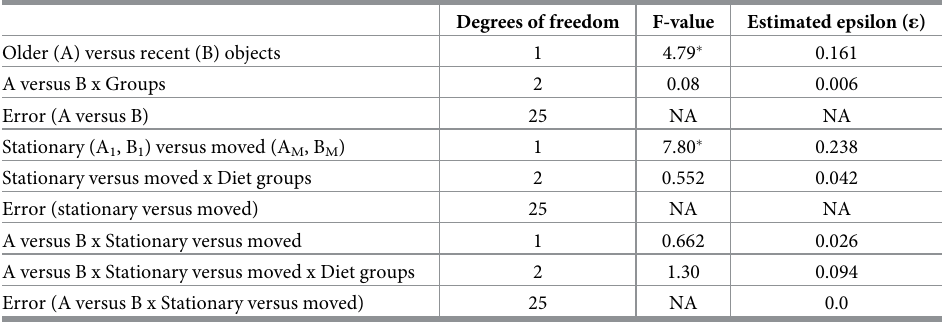
Table 4. Summary of 3 x 2 x 2 ANOVA (diet group x object movement x older versus recent object) results of 4-object exploration using the Greenhouse-Gassier adjustment.